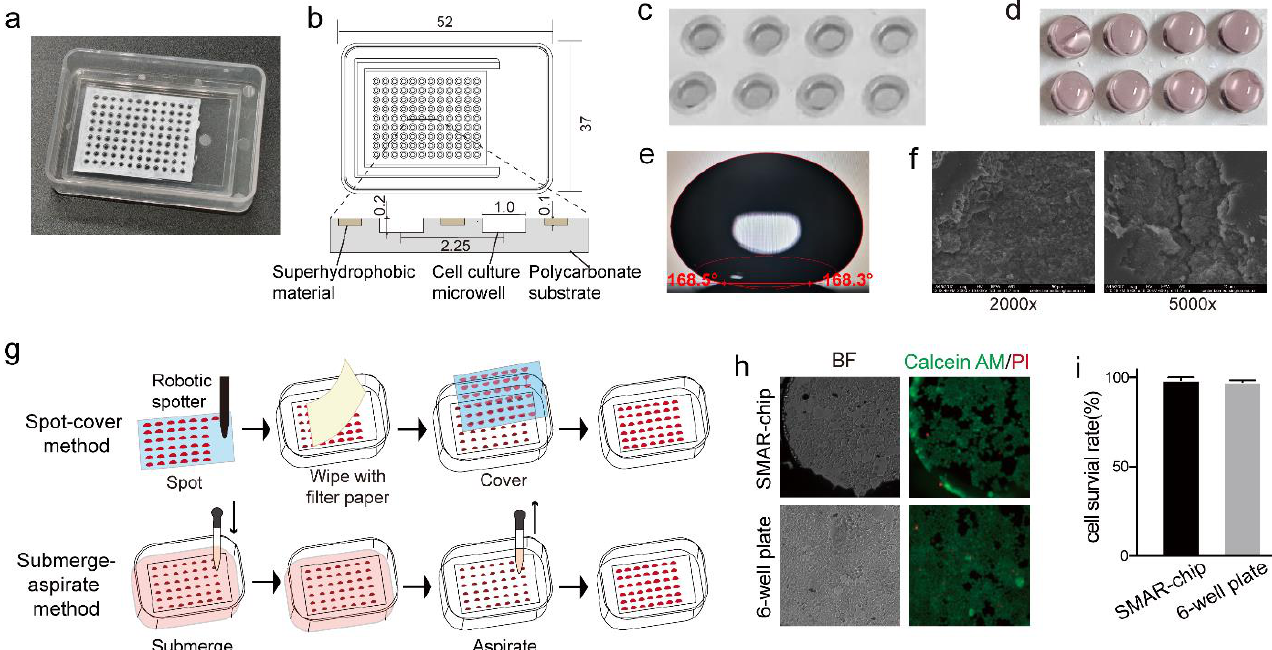
Figure 2. Illustration of the SMAR-chip. ( a ) The macroimage of the SMAR-chip. ( b ) The dimension of the SMAR-chip (unit: mm). ( c ) Image showing the microwell and the surrounding superhydrophobic layer. ( d ) Image of droplets in the microwells. ( e ) Contact angle of the superhydrophobic paint. ( f ) SEM images of the superhydrophobic paint. ( g ) Methods for reagent delivery on the SMAR-chip. ( h ) Images of the live/dead assay. ( i ) Quantification of cell survival rate.